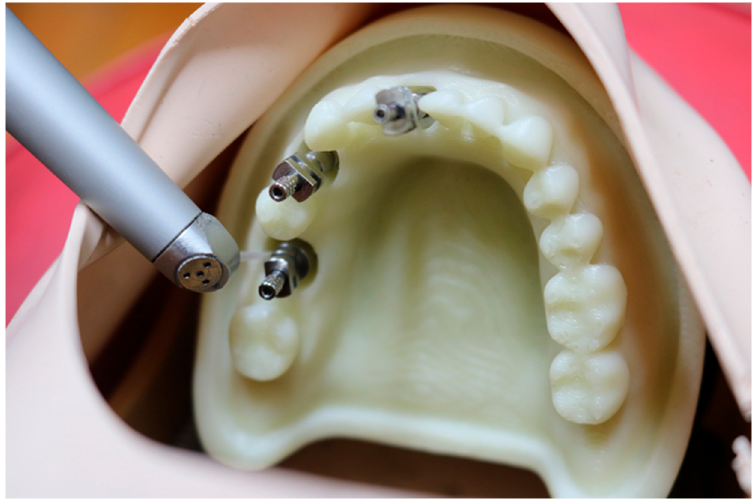
Figure 3. Illustration of laser treatment of the in vitro peri-implantitis model.